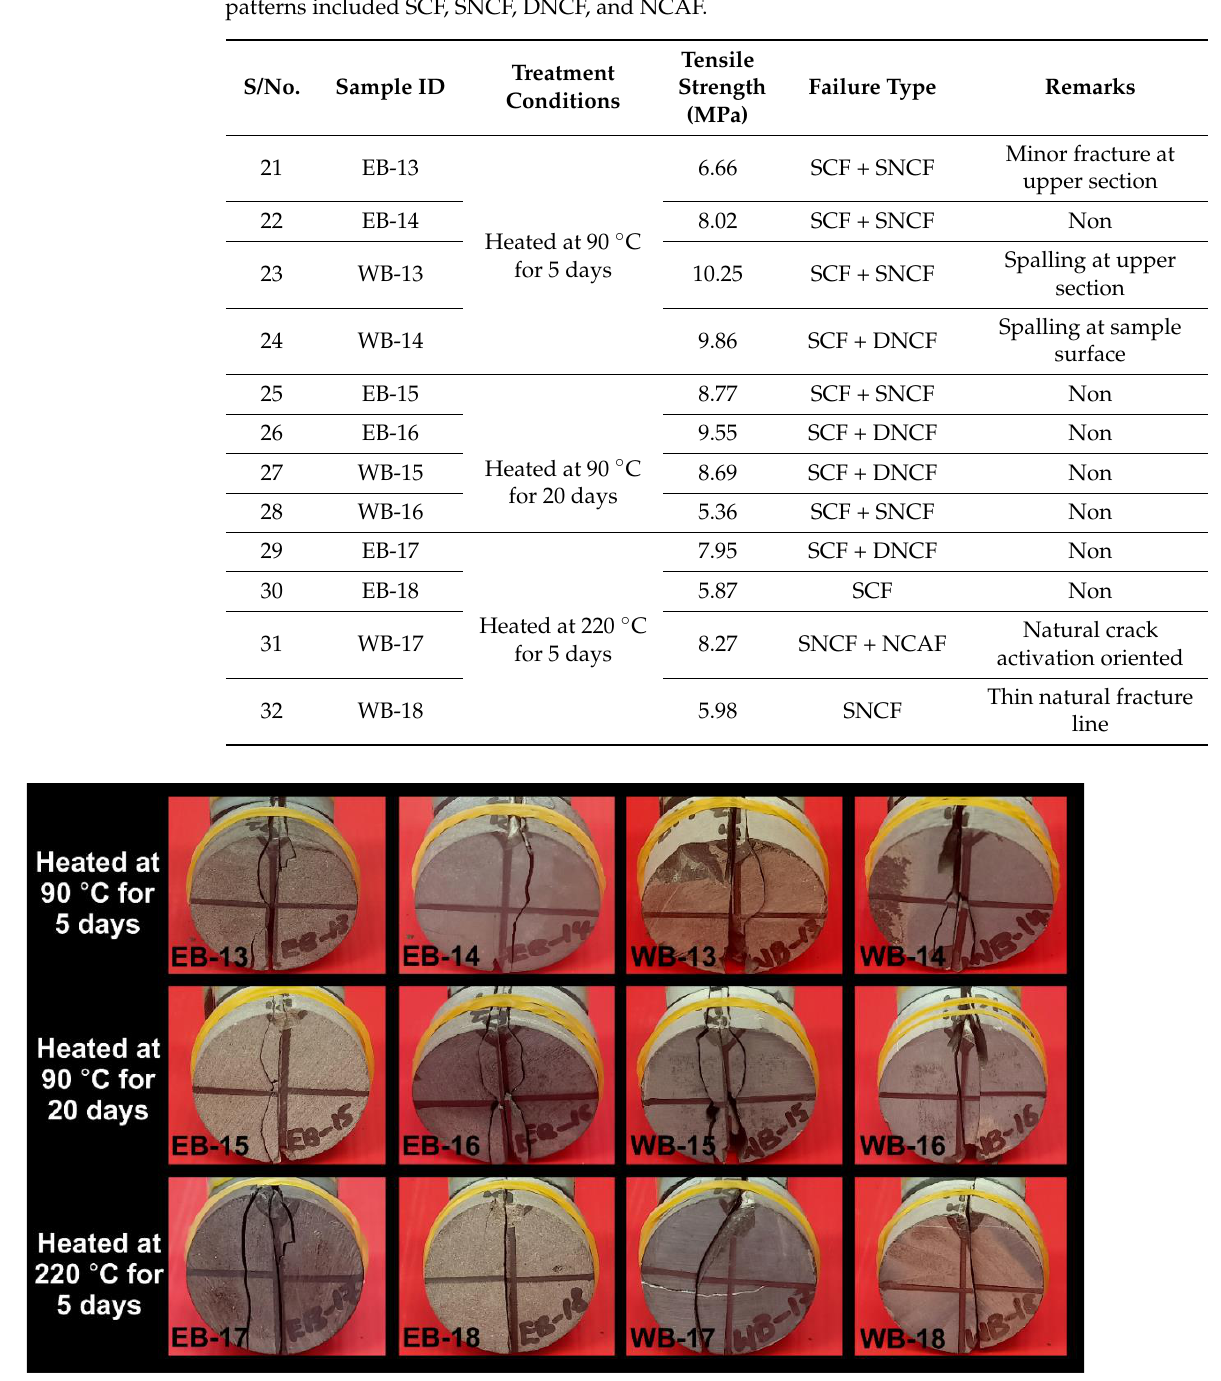
Table 3. Tensile failure classifications for samples subjected to reservoir temperature controlled conditions of 90 ◦ C for 5 and 20 days and 220 ◦ C for 5 days prior to BITS testing. Identified failure patterns included SCF, SNCF, DNCF, and NCAF.